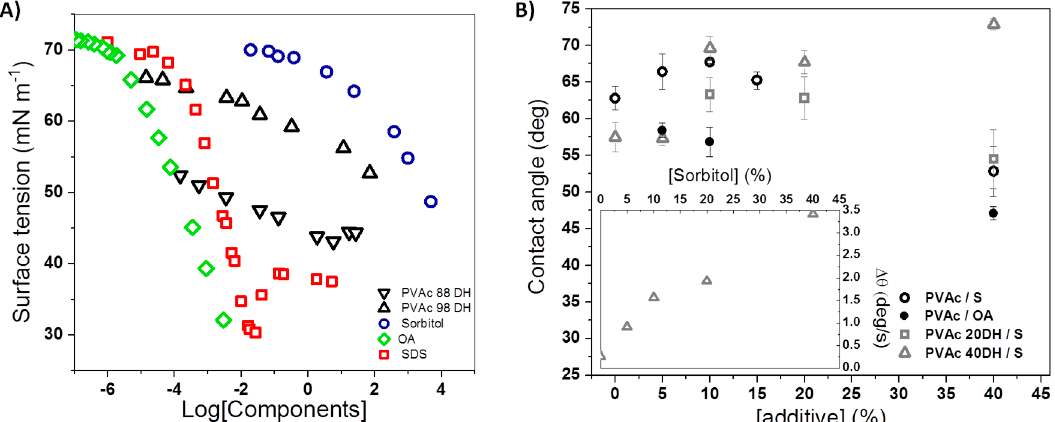
Figure 3. ( A ) Surface tension of PVAc 98DH, PVAc 90 DH, sorbitol, and SDS aqueous solution as a function of their concentration and of OA in 0.005 M hydrochloric acid measured by Lunkenheimer et al. [40]. ( B ) Contact angle values of PVAc, PVAc 20DH, and PVAc 40DH films as a function of sorbitol and OA mass fraction. The rate of contact angle variations over 30 s is shown in the inset as a function of sorbitol mass fraction in films of PVAc 40DH.